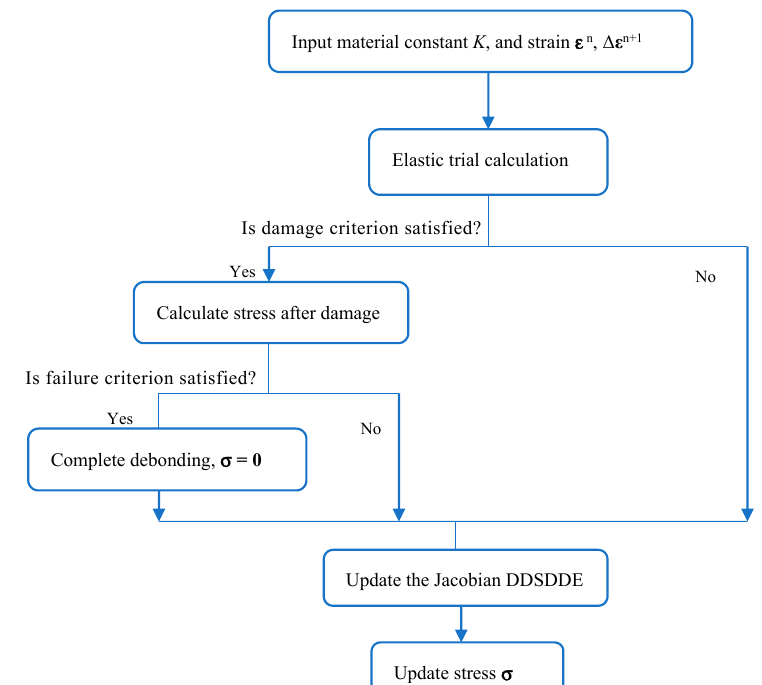
Figure 6. Flowchart for the constitutive model of the interface. Table 2. Material parameters of the steel/concrete interface.